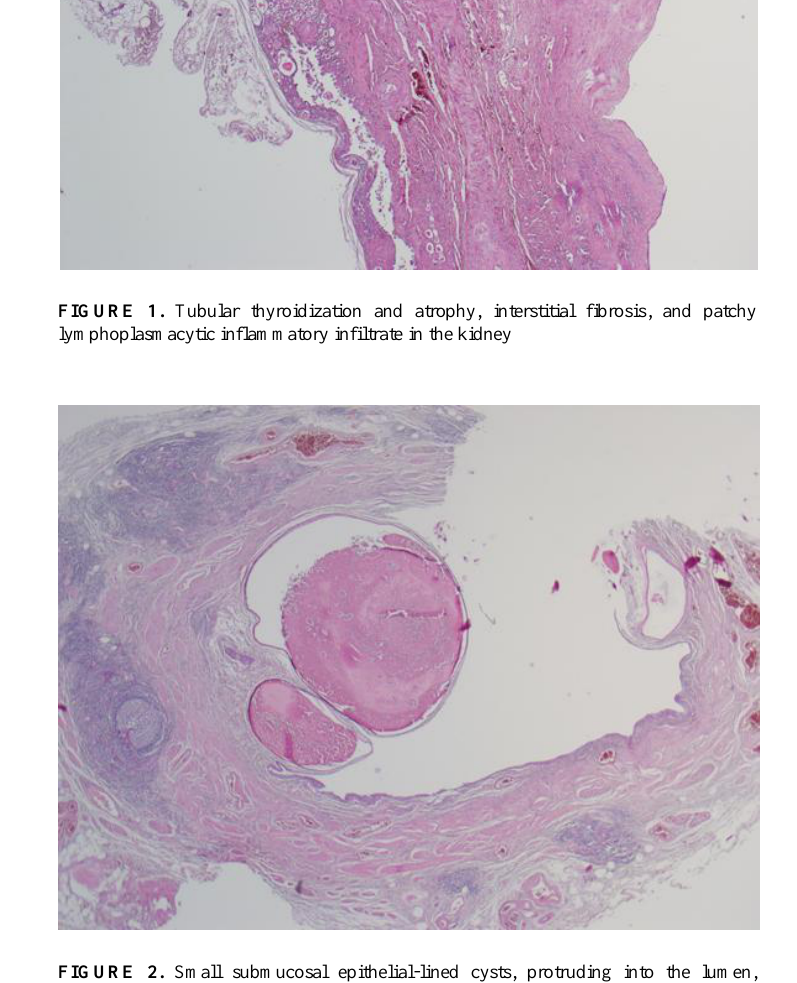
FIGURE 2. Small submucosal epithelial-lined cysts, protruding into the lumen, surrounded by nonspecific inflammatory